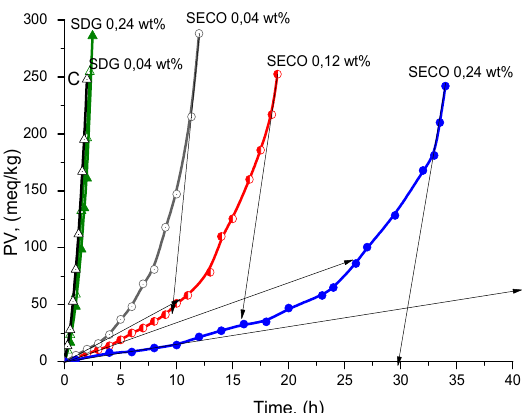
Figure 5. Kinetic curves of LOOH accumulation during the complete TGSO autoxidation process at 80 °C in absence (C/Control) and in presence of flaxseed lignin-secoizolariciresinol (SECO) and secoisolariciresinol diglucoside (SDG).